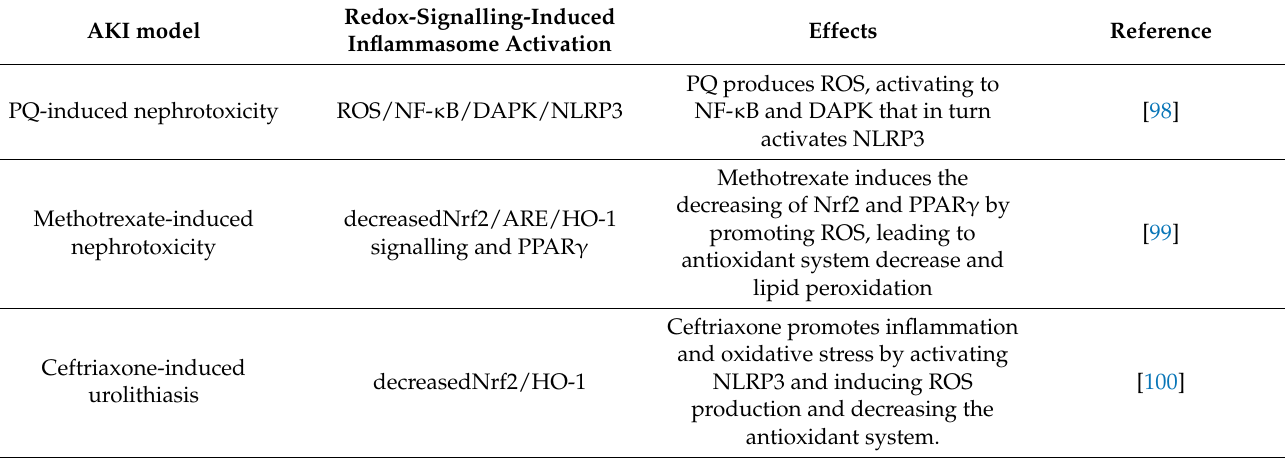
Table 2. Redox-signalling pathways-induced inflammasome activation in